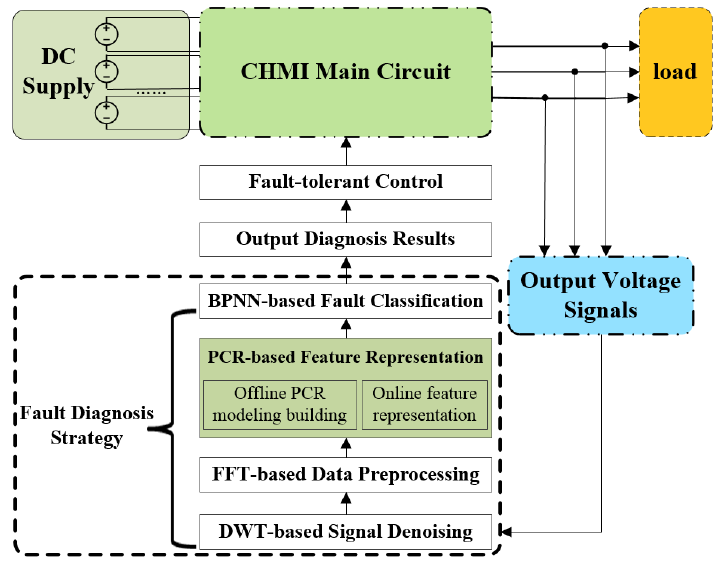
Figure 6. Structure of fault diagnosis strategy used in the inverter